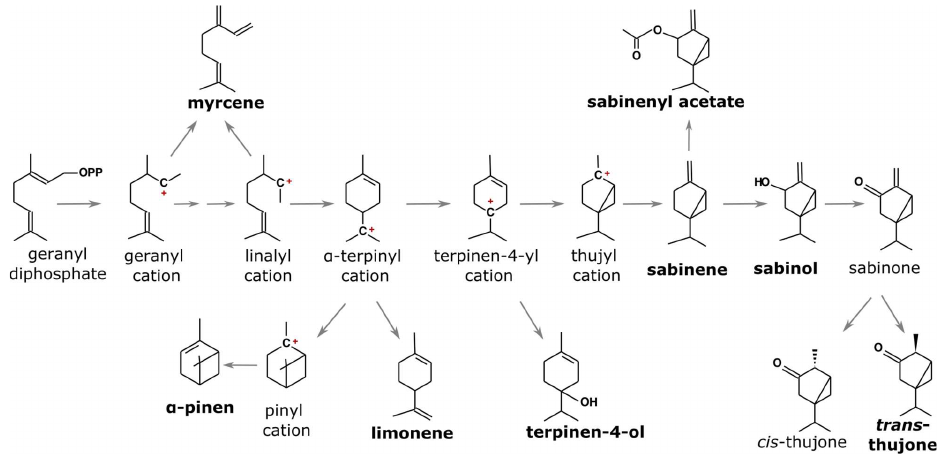
Figure 1. Biosynthetic pathway for the most common savin juniper terpenoids, adapted from [26]. While the species has been proven as hardy and is widely grown for ornamental purposes, it cannot withstand competition with other shrubs or trees in its natural habi- tat. As these remaining fragments of natural populations are important gene pools, it is important to preserve their genetic resources and reconstruct or find new habitats for this species. Thus, the starting point in these efforts is determining the genetic diversity and structure of natural populations of J. sabina var. balkanensis . However, previous investi- gations of the population variability using molecular markers have only been conducted in Asia [2], where two genetic pools were discovered. Recently, different authors have suggested using inter-simple sequence repeat (ISSR) markers as an alternative system with reliability and advantages over other molecular marker systems [27–30]. This tech- nique involves the amplification of genomic segments flanked by inversely oriented mi- crosatellite sequences. These regions are amplified using primers based on SSRs an- chored with a couple of nucleotides. The resulting PCR products are multiple bands of different lengths that could be coded into a presence/absence matrix. ISSR markers are dominant markers that show Mendelian inheritance.